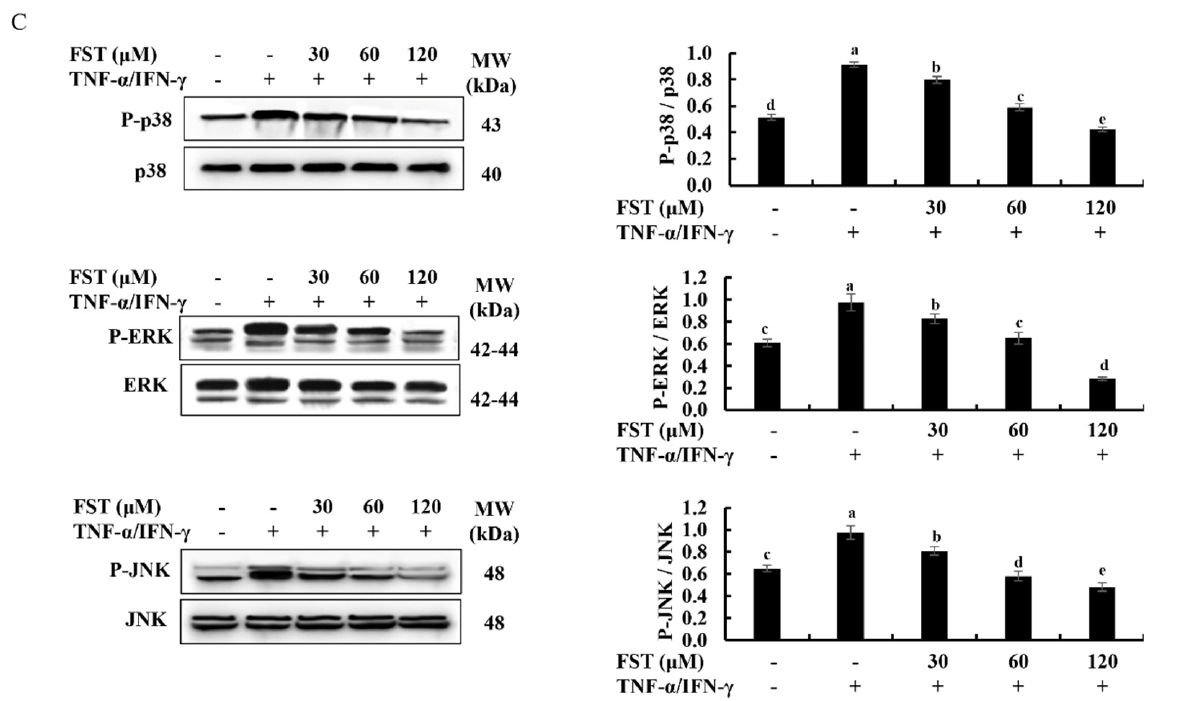
Figure 5. Protective effect of FST on NF- κ B and MAPK inflammatory mediators in TNF- α /IFN- γ - stimulated HDF cells. Levels of molecular mediators were assessed by ( A ) western blot analysis for NF- κ B, ( B ) evaluation of NF- κ B p65 nuclear translocation by immunofluorescence analysis, and ( C ) western blot analysis of MAPK signaling. All experiments were performed in triplicate ( n = 3) to determine the repeatability, and lettered error bars were significantly different ( p <